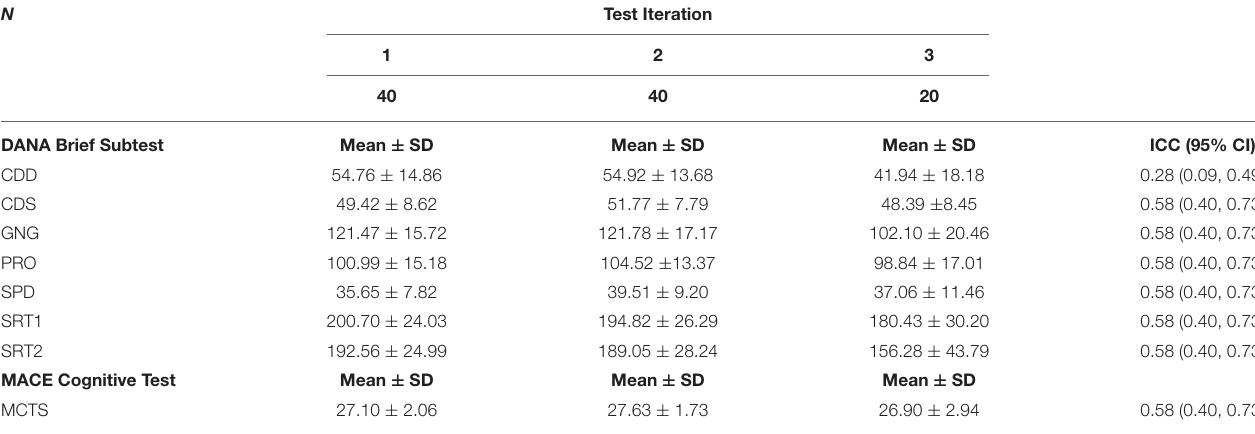
TABLE 1 | Group summary statistics and reliability, as measured by intra-class correlation coefficient (ICC), for DANA Brief mean throughput scores and the MACE cognitive test scores for each test iteration. N Test